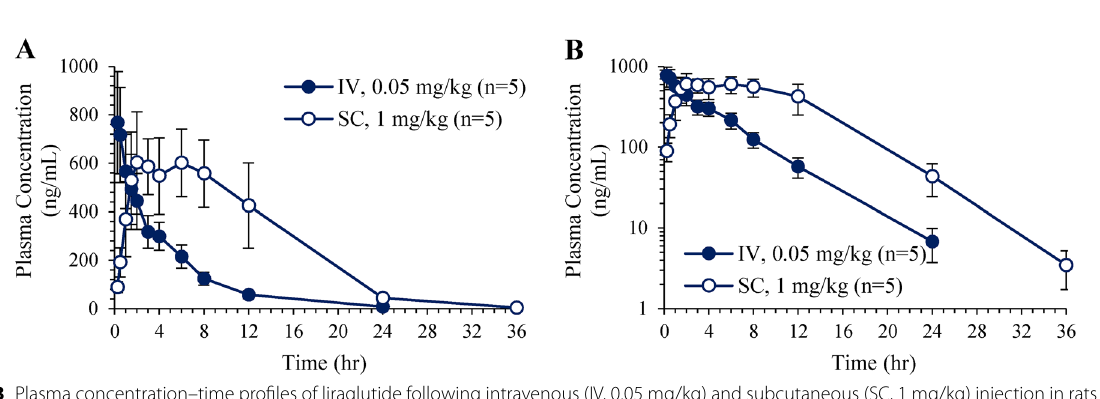
70 °C; autosampler, 24 h in the autosampler; freeze/thaw, 3 freeze/thaw cycles −